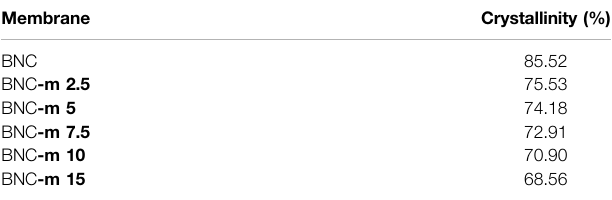
TABLE 3 | Degrees of crystallinity for the membranes.